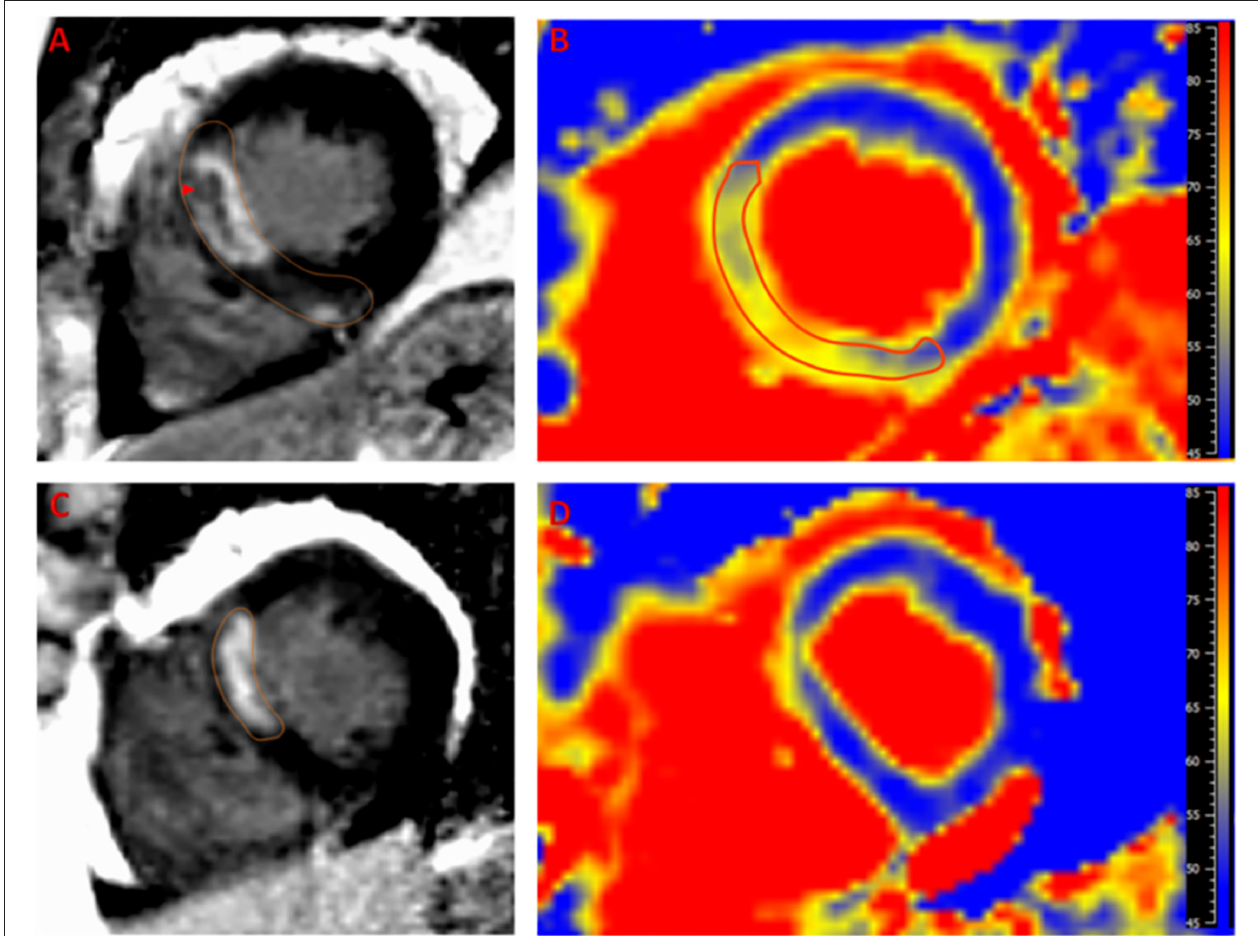
FIGURE 1 | Example of a case of left anterior descending artery infarction. Late gadolinium enhancement (LGE) is noted in the septal segments (A) with area microvascular obstruction (arrow head). Edema (yellow hue) as detected by T2 mapping (B) extends beyond the LGE area with notable decreased T2 time in the microvascular obstruction region indicating hemorrhage. The 6-month follow up scan shows marked regression of LGE (C) and edema (D) with residual infarction in the anteroseptum that appears thinned on T2 map with minimal residual T2 elevation that is likely related to fibrous tissue deposition. Reference T2 time for normal myocardium in our laboratory is <